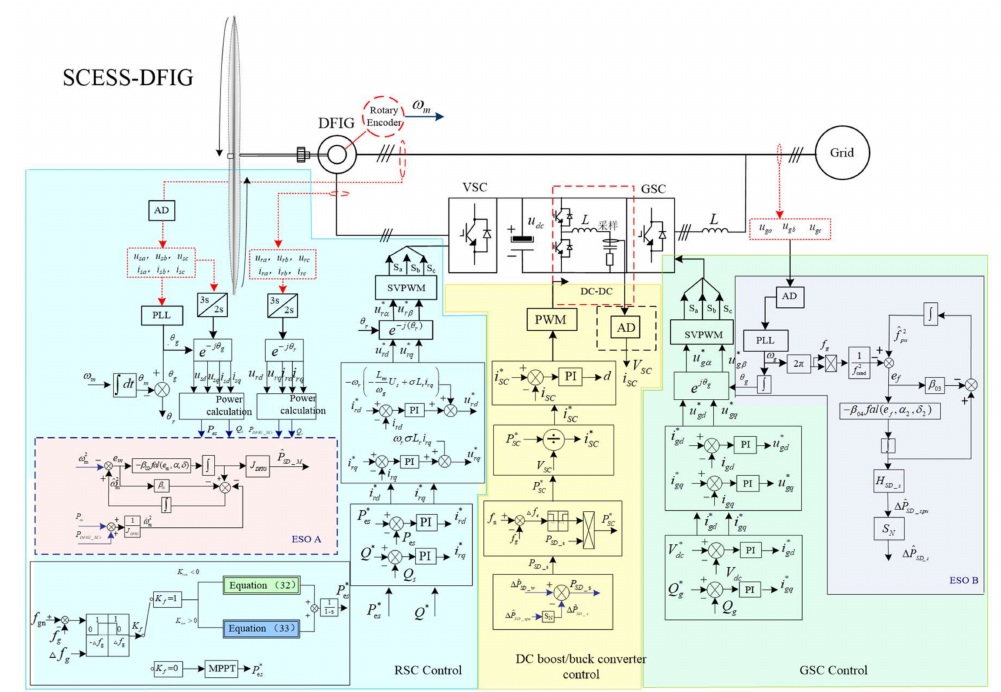
Figure 9. A frequency inertia response control strategy for SCESS-DFIG power grid considering wind speed changes. SVPWM: space vector pulse width modulation; PI: